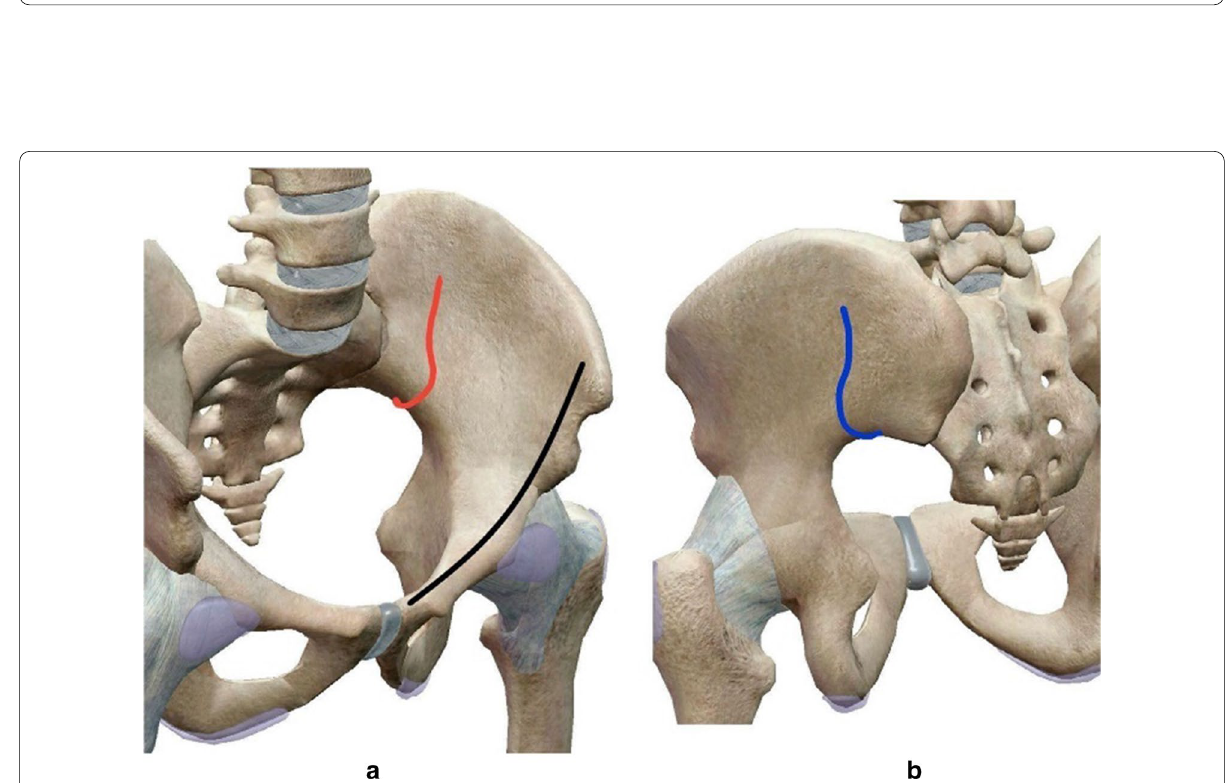
Fig. 17 The creation of the "teardrop" view. a The red line represents the contour of the inner table and sciatic notch creating the medial half of the "teardrop". The black line represents the contour of the anterior ilium that creates a portion of the teardrop. b The blue line represents the contour of the opposite lateral half of the "teardrop". The ideal "teardrop" view results from an overlap of the blue, red, and black lines